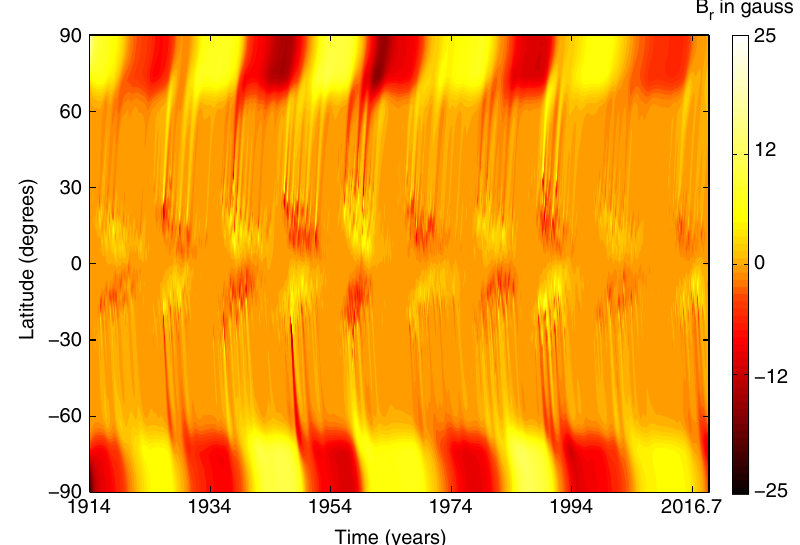
Fig. 1 Simulated butter fl y diagram of the solar cycle. Century-scale simulation of solar surface magnetic fi eld evolution covering sunspot cycle 15 to the currently on-going cycle 24. The butter fl y diagram depicts the spatio-temporal variation of the longitudinally averaged radial magnetic fi eld (in gauss) on the Sun ’ s